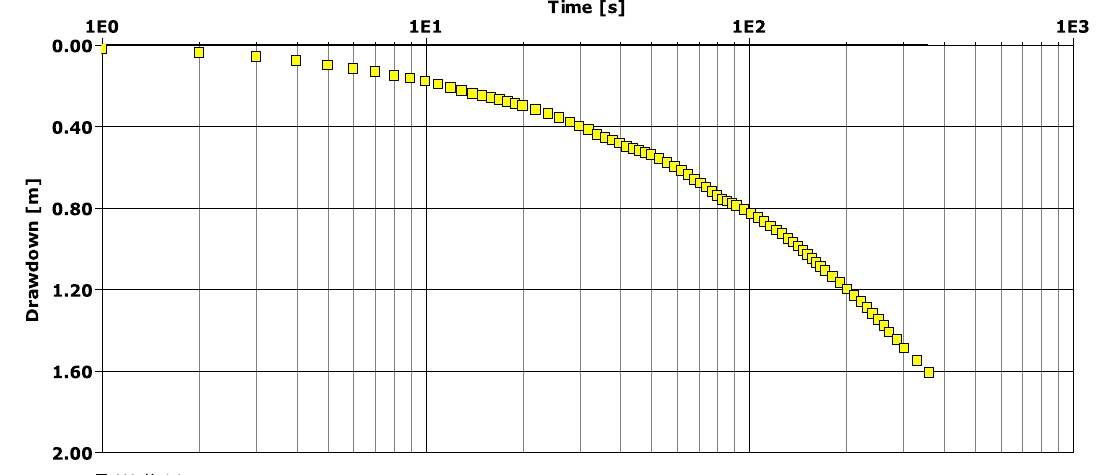
Fig. 28 Theis’s method of pumping